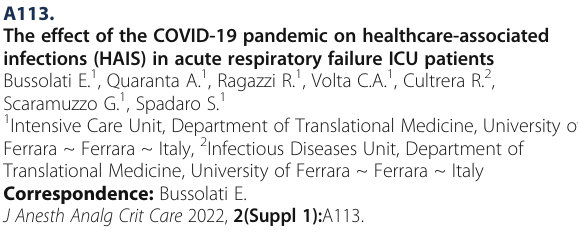
Table 1 (abstract A113). Baseline characteristics at ICU admission, comorbidities, entrance diagnosis and clinical features in the study population